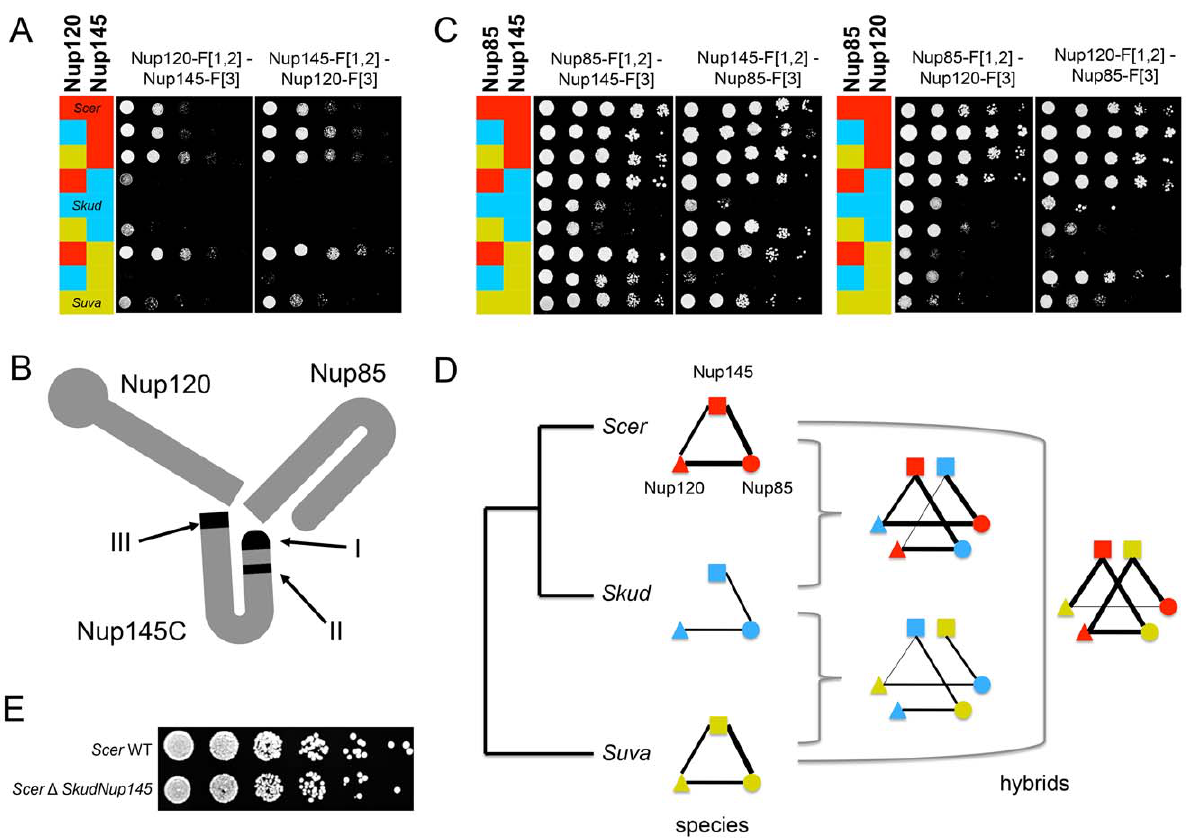
Figure 5. The absence of Nup120-Nup145C interaction in Skud is likely a PPI loss. ( A ) Spot assays on Methotrexate medium (six days of growth at 30 u C) to dissect the interaction in Scer (red), Skud (blue), Suva (yellow) and their hybrids. The interaction between Nup145C from Scer and Nup120 from Scer , Skud or Suva is detected, whereas it is lost when Nup145C comes from Skud . The interaction was also absent when it involved Nup120 from Skud and Nup145 from Suva . ( B ) Schematic structure of the Scer Nup120-Nup85-Nup145 sub-complex adapted from Fernandez- Martinez et al. [43]. The three interacting domains are indicated in black. ( C ) Interactions between Nup85 and Nup145C or Nup120 in three species and their hybrids confirm that not all Nup145C interactions are lost. ( D ) Evolutionary tree of Scer , Skud and Suva and schematic representation of Nup145-Nup120-Nup85 interactions in species and hybrids according to spot assays ( A–C ), revealing several other loss of interaction in hybrids with Suva . Line width is proportional to the number of spot growth observed for each interaction. ( E ) Similar growth for BY4741 Scer wild type (WT) and modified strains ( D Skud-NUP145 ) suggest that Skud-Nup145 complements the absence of Scer-Nup145 (YPD medium, two days of growth at 30 u C), as Nup145 is essential for growth in Scer